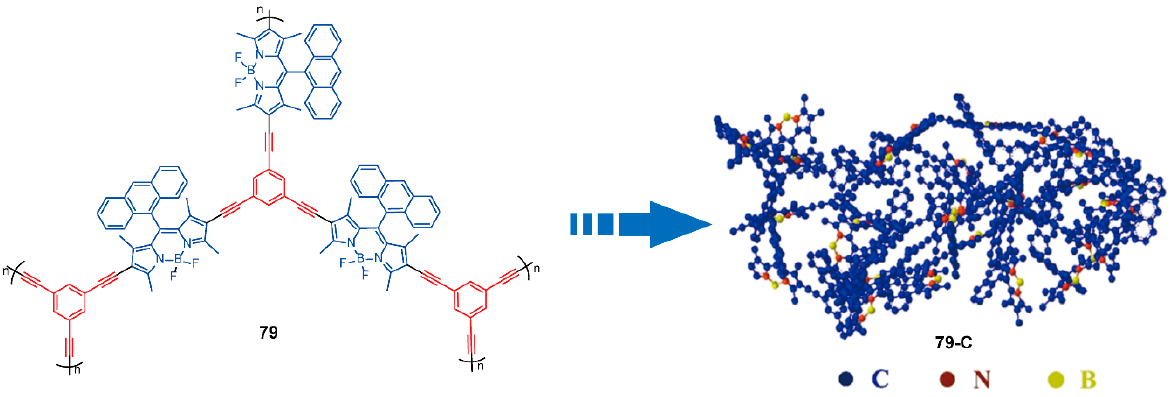
Figure 27. Chemical structures of polymers 79 and diagram of 79-C (Reproduced with permission from Reference [102]. Copyright @ 2018 ACS